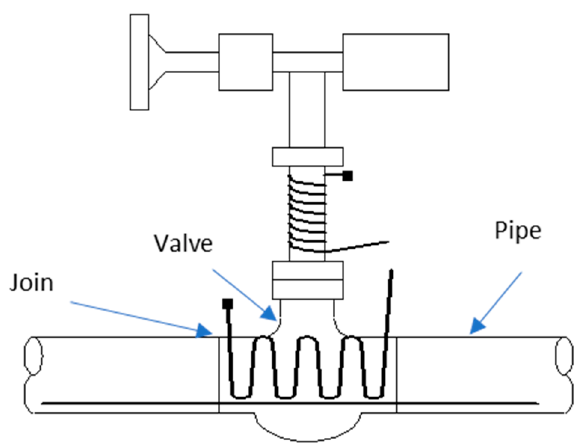
Figure 2. Several mounting configurations for heat trace cables based on the type of pipe element (valve, joint, or pipe).